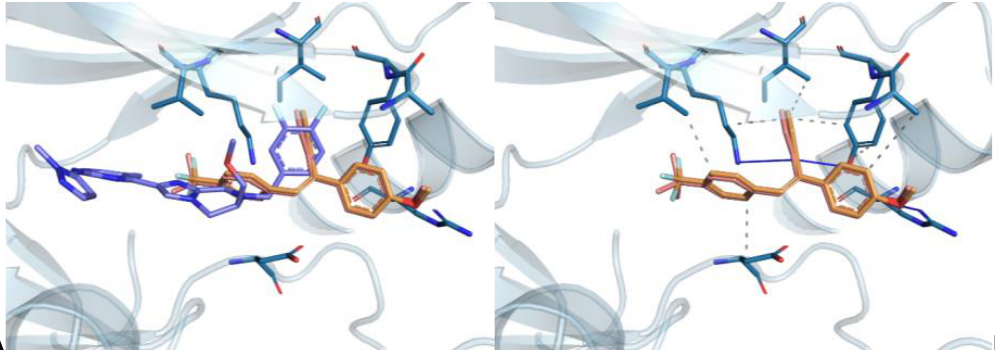
Figure 11. Predicted binding modes of compounds 10a (in salmon) and 12a (in orange) in the ERK-2 binding site (PDB ID: 6SLG) ( A ) in comparison with the 6SLG co-crystallized ligand (in blue) and ( B ) with detailed information about the interactions established between our compounds and the ERK-2 binding site obtained using PLIP [53] (grey dotted lines: hydrophobic, blue lines: HB).